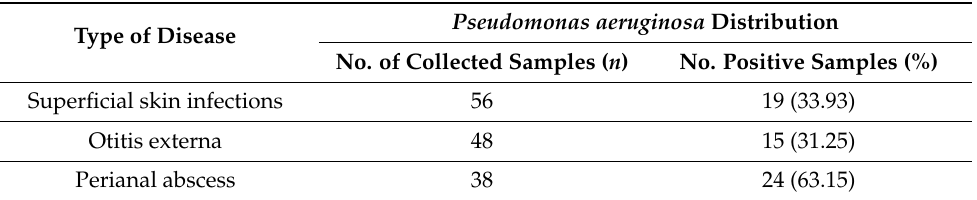
Table 1. Distribution of Pseudomonas aeruginosa isolates from dogs with superficial infections. Pseudomonas aeruginosa Distribution Type of Disease